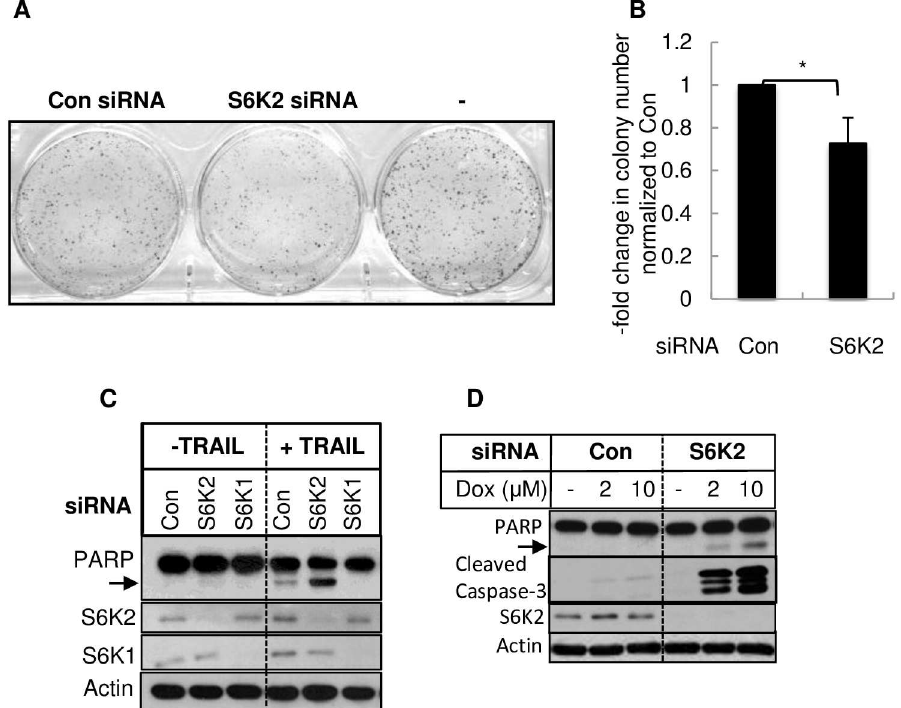
Fig 1. Knockdown of S6K2 decreasedsurvival of T47D cells. Cells were transfected with or without control non-targeting siRNA or S6K2 siRNA. (A). Clonogenic assay was performed as describedunder “Materials and Methods.” (B). The bar graph representsaveragecolonies ± SD of triplicate plates. * , p < 0.05. (C). T47D cells were transfected with indicatedsiRNAs. 48 h after transfection, cells were treated with 0.25 nM TRAIL for 24 h, and Western blot analysiswas performed with indicatedantibodies.(D). T47D cells were transfected with indicatedsiRNAs. 48 h after transfection, cells were treated with indicatedconcentrations of doxorubicin for 24 h and Western blot analysiswas performed with indicatedantibodies.Actin was used as a loadingcontrol.